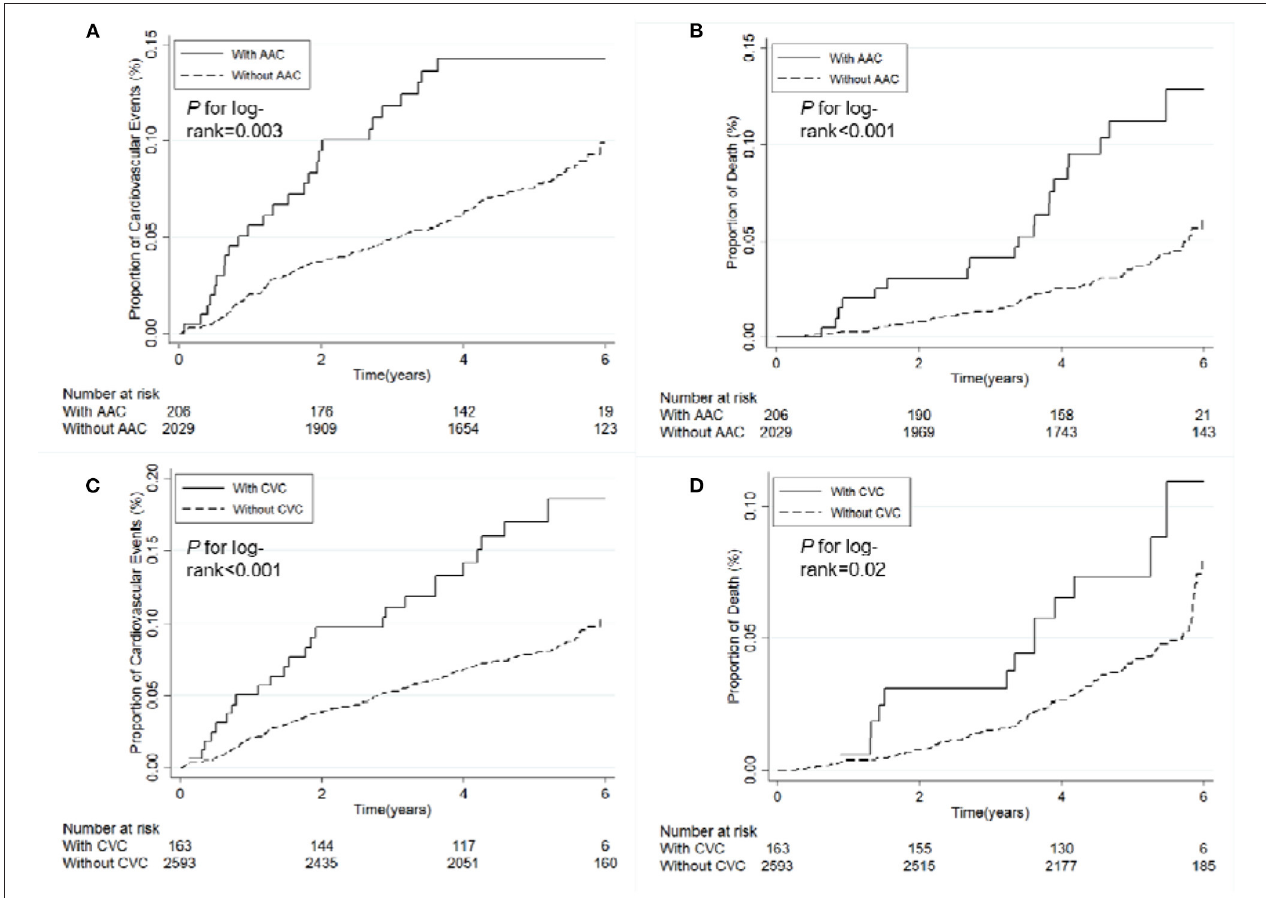
FIGURE 3 | Kaplan–Meier curves for cardiovascular events or death according to presence or absence of AAC or CVC. (A) Category of AAC and risk of cardiovascular events. (B) Category of AAC and risk of death. (C) Category of CVC and risk of cardiovascular events. (D) Category of CVC and risk of death. AAC, abdominal aortic calcification; CVC, cardiac valvular